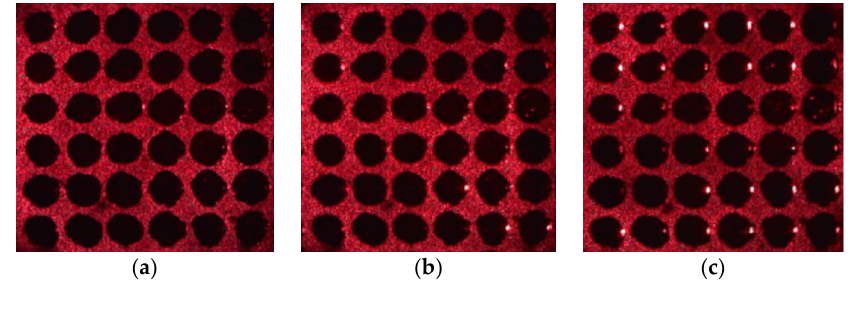
Figure 10. ( a ) 0 ◦ ; ( b ) 3 ◦ ; ( c ) 7 ◦ .